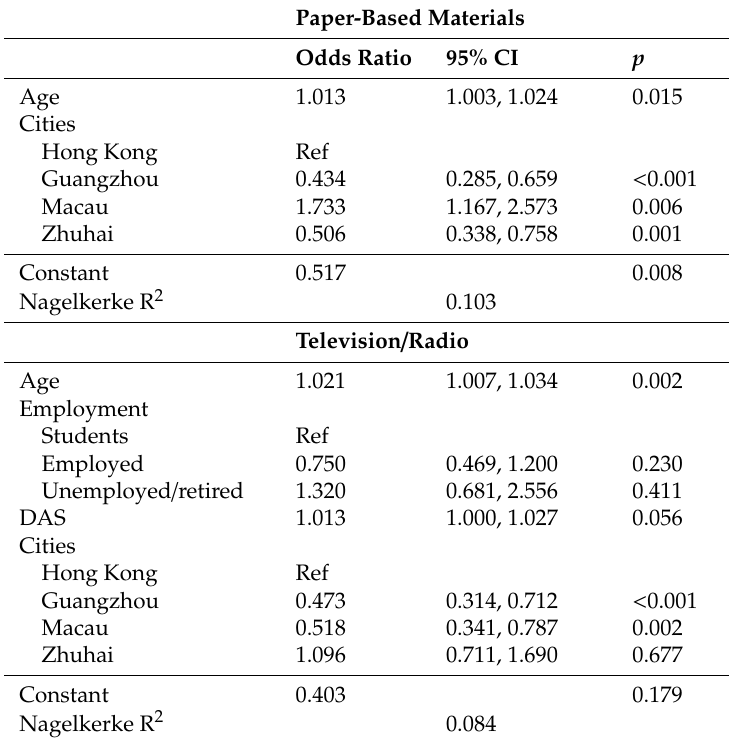
Table 4. Preferred traditional media for receiving dementia